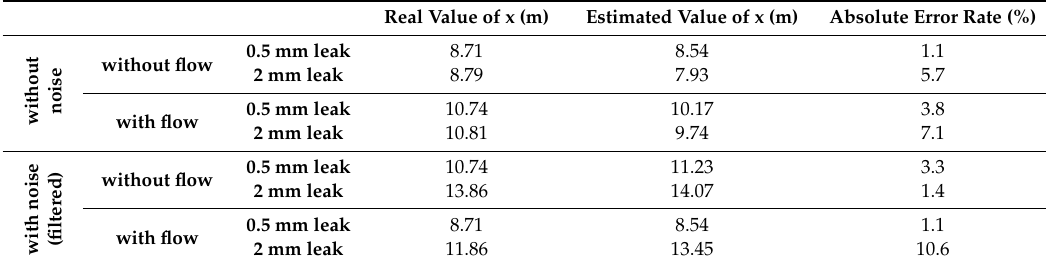
Table 3. Results from the CC method for 15 m distance between the sensors.